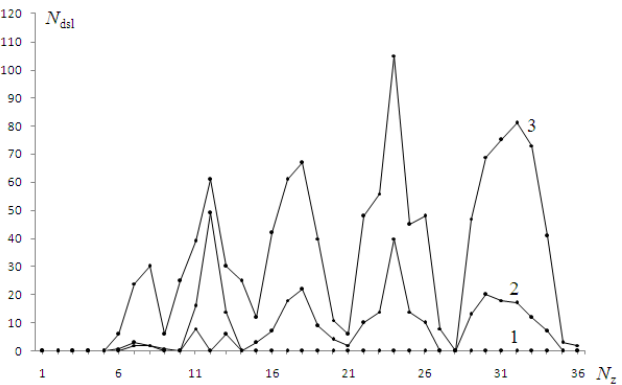
Figure 9. The same as in Figure 8, but the phase was specified by polynomial No. 9 (trefoil). N dsl = 58 ( a ), N dsl = 43 ( b ) и N dsl = 7 ( c ).